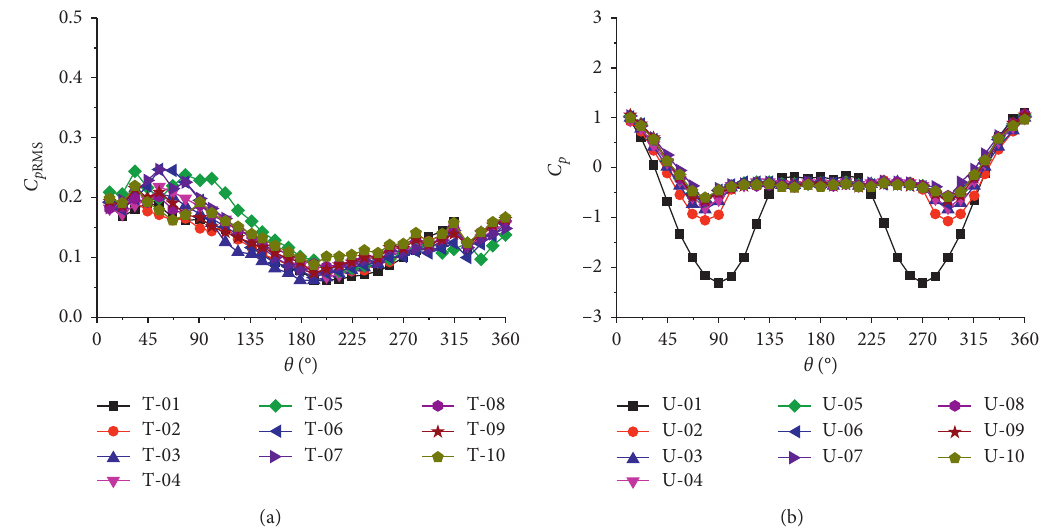
Figure 14: Effects of roughness on wind pressure: (a) fluctuating wind pressure coefficient and (b) mean wind pressure